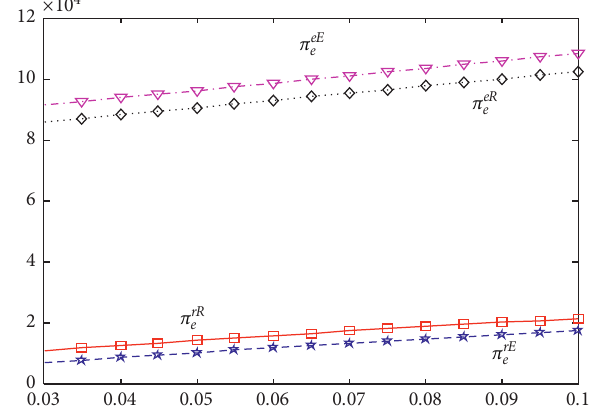
Figure 7: Optimal profit of e-platform over ρ .